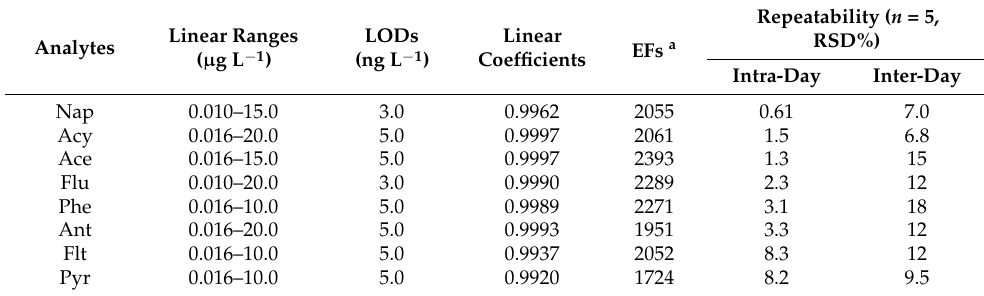
Table 1. The results of the method evaluation.